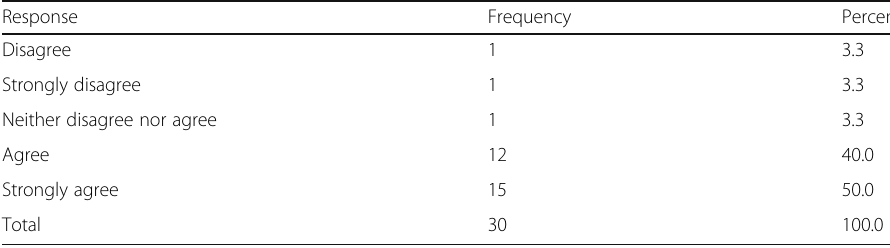
Table 10 Use of appointment systems for ship arrival and departure Response Frequency Percent Disagree 1 3.3 Strongly disagree 1 3.3 Neither disagree nor agree 1 3.3 Agree 12 40.0 Strongly agree 15 50.0 30